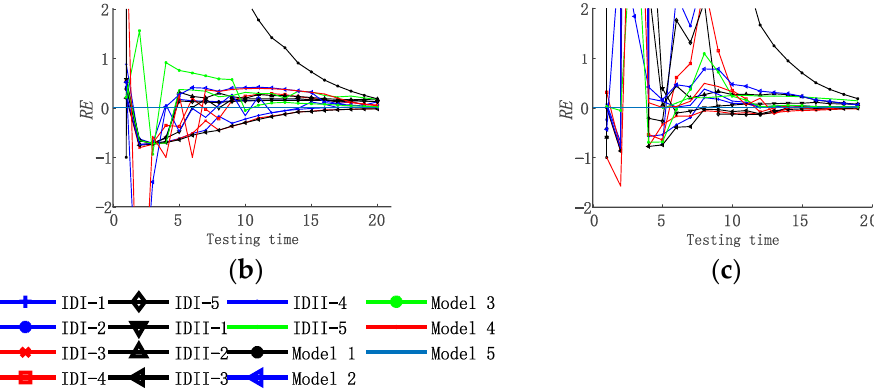
Figure 5. Prediction Curves of Models. ( a ) Prediction Curves of Models on DS1; ( b ) Prediction Curves of Models on DS2; ( c ) Prediction Curves of Models on DS3.